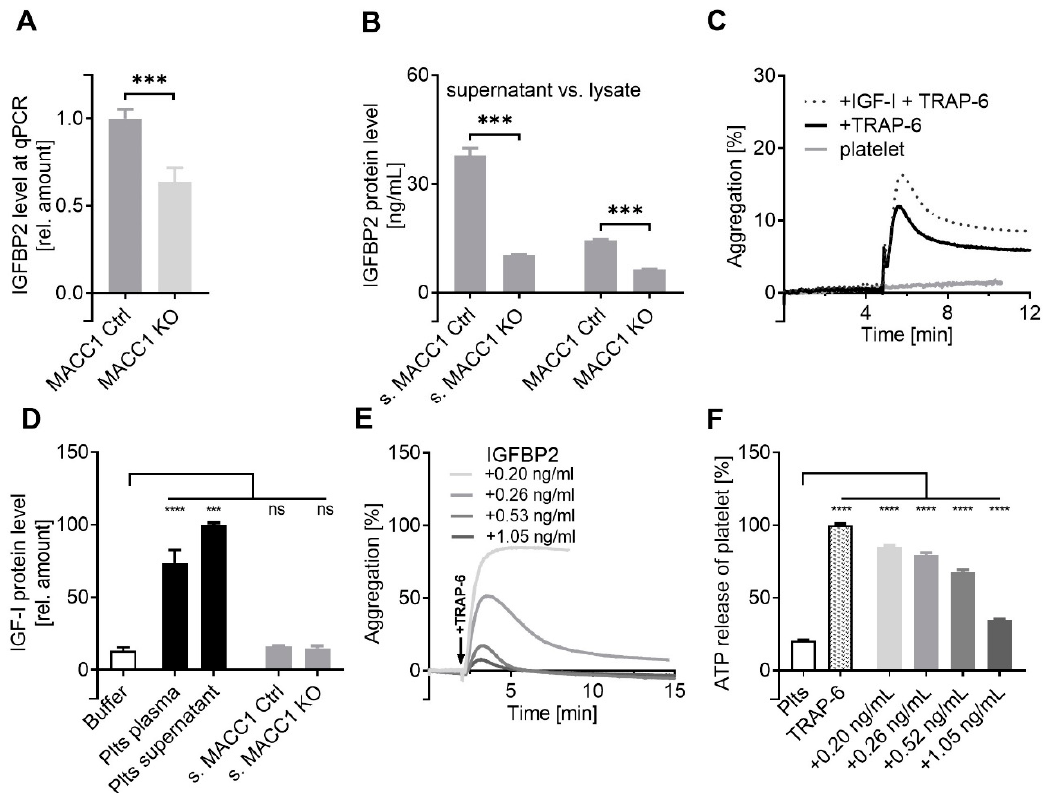
Figure 3. MACC1 activity is directly related to IGFBP2 expression, which interferes with platelet activation. The downregulation of IGFBP2 in the MACC1 KO variant of SW620 cells was indicated at the mRNA level by qPCR ( A ) and confirmed at the protein level by ELISA ( B ). ELISA data confirm the lower expression of IGFBP2 by the MACC1 KO variant of SW620 cells, either in supernatant (s. MACC1 Ctrl vs. s.MACC1 KO, left columns) and at a lower level in the cell lysate (right columns). ( C ) IGF-I is costimulatory for platelet activation and accelerates the effect of 7.5 µM TRAP-6 to induce platelet aggregation. ( D ) IGF-I is associated with platelets and found in platelet plasma or supernatant after activation, but not in considerable amounts in supernatant of SW620 cells. ( E ) Recombinant IGFBP2 is able to block concentration-dependently the activity of TRAP-6 to induce platelet aggregation and ( F ), significantly, the platelet ATP release. *** p < 0.001; **** p < 0.0001 .